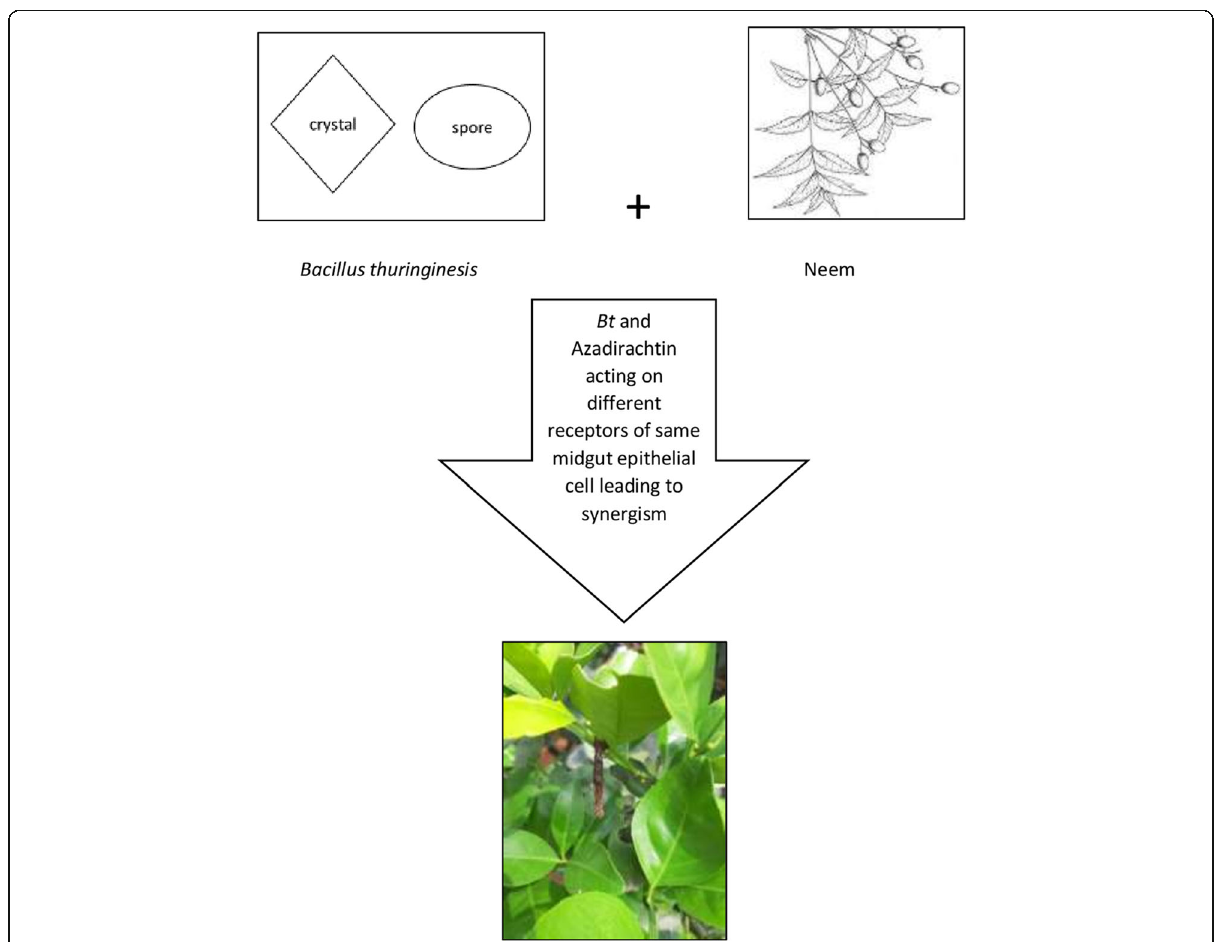
Fig. 1 Synergism of botanicals with entomopathogenic bacteria. Mummified caterpillar of citrus looper ( Anacamptodes fragilaria Grossbeck) observed after application of Bt and azadirachtin combination (photo from trials conducted at CRS,